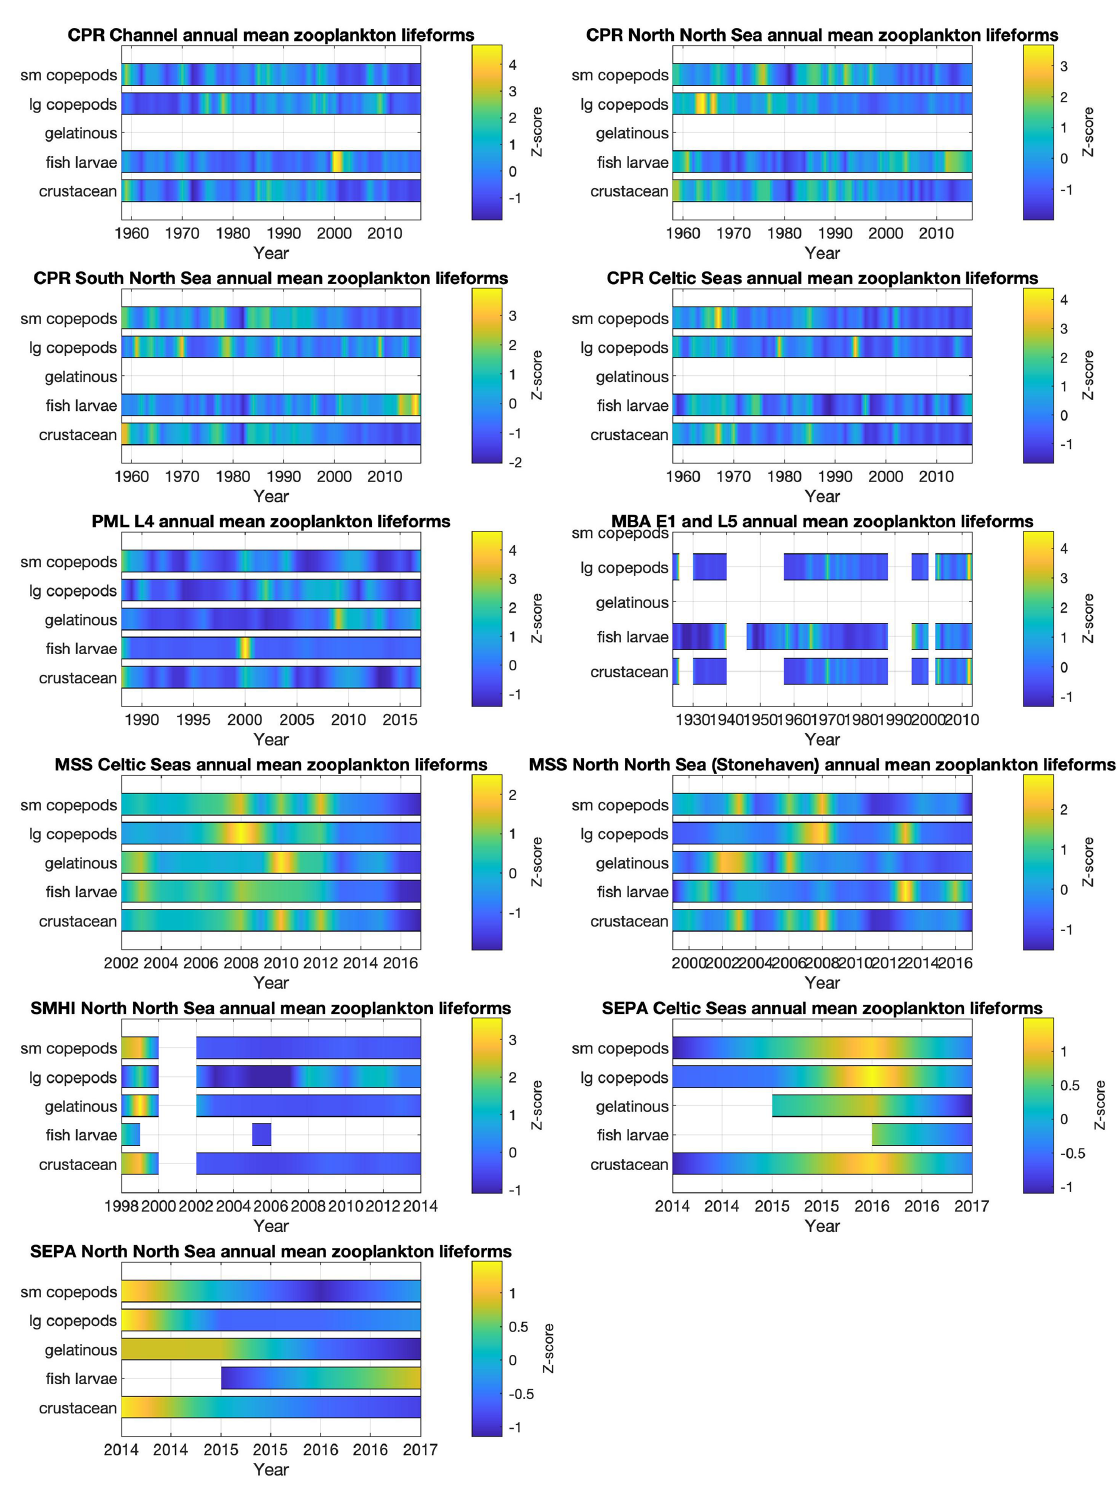
Figure 8. Zooplankton lifeform annual means, by data provider and region. Colour indicates lifeform abundance relative to the long-term mean of each lifeform within each region and dataset as standardized z score (Glover et al., 2005): scores of zero are equal to the long-term mean, positive scores (in green/yellow) signify values above the long-term mean, and negative scores signify values below the long-term mean (in blue). Only those lifeforms that have been assigned a confidence level of “high” are shown (see Tables 2 and 3). Regions are defined in Fig.